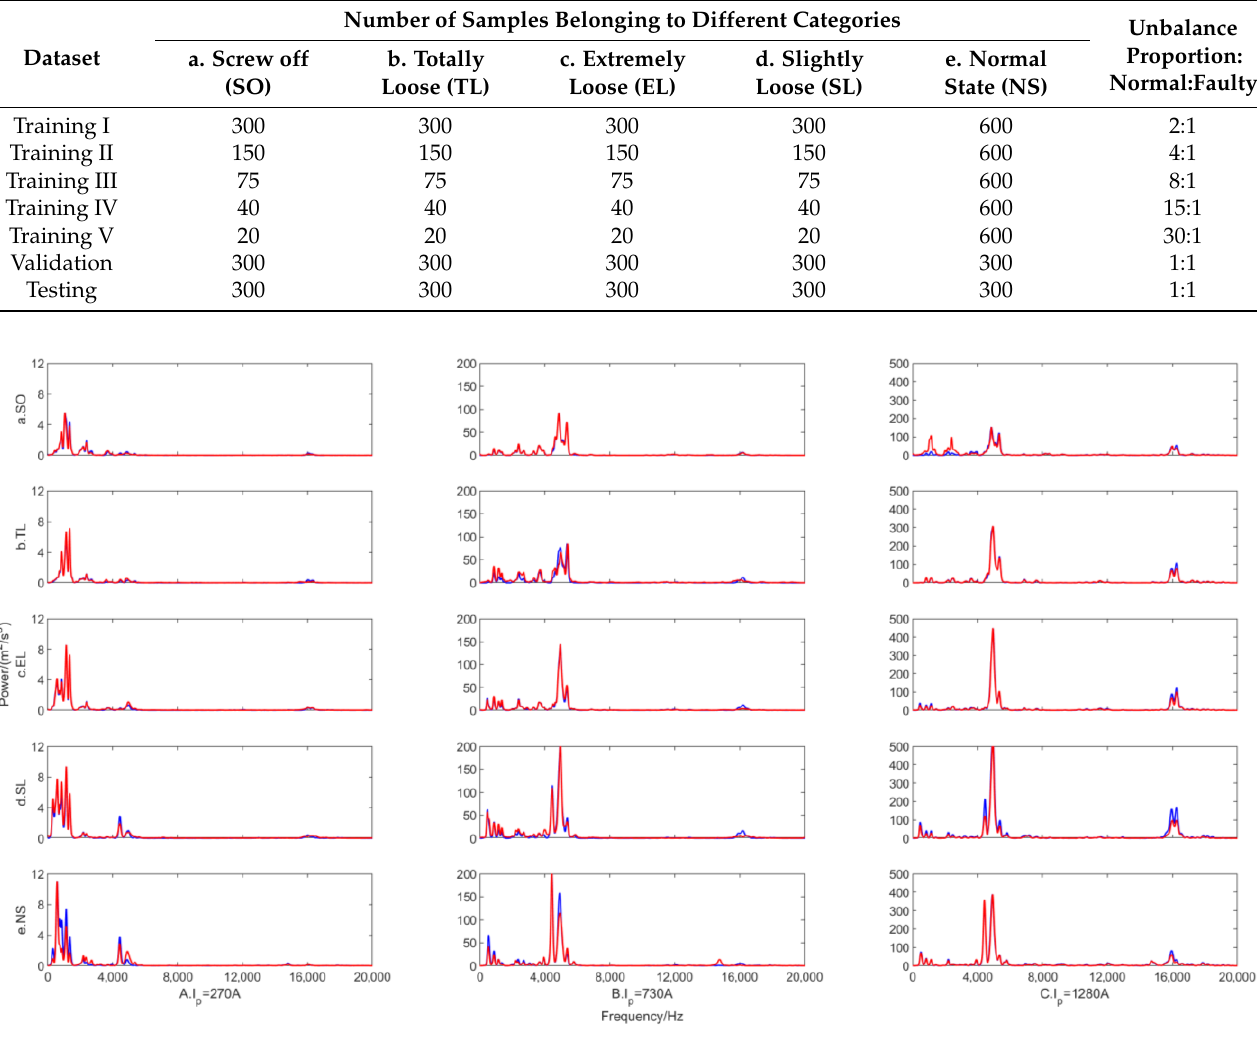
Table 5. Datasets organization.